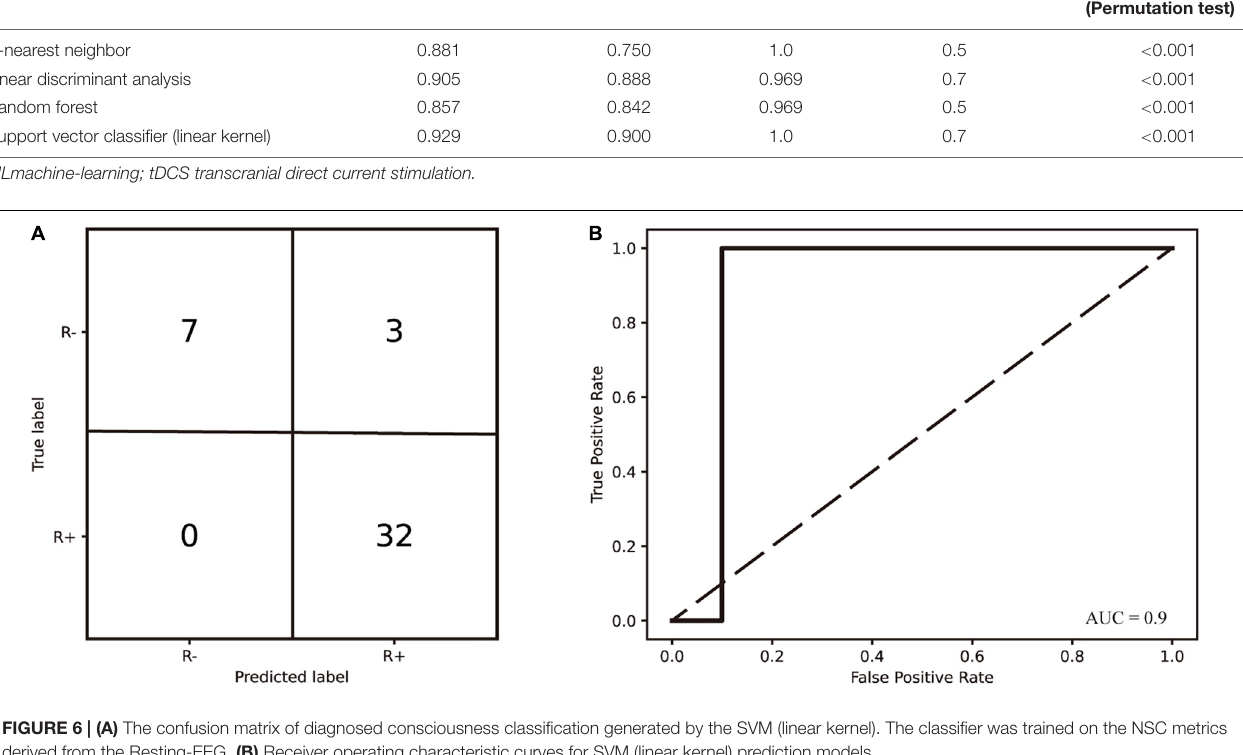
loop, and the best model and best parameters were selected.